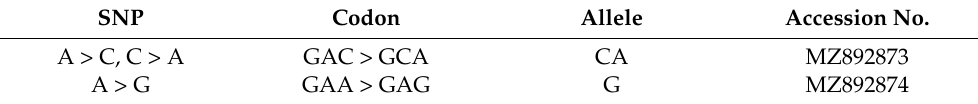
Table 8. Submission of nucleotide sequences with SNPs to the NCBI GenBank.